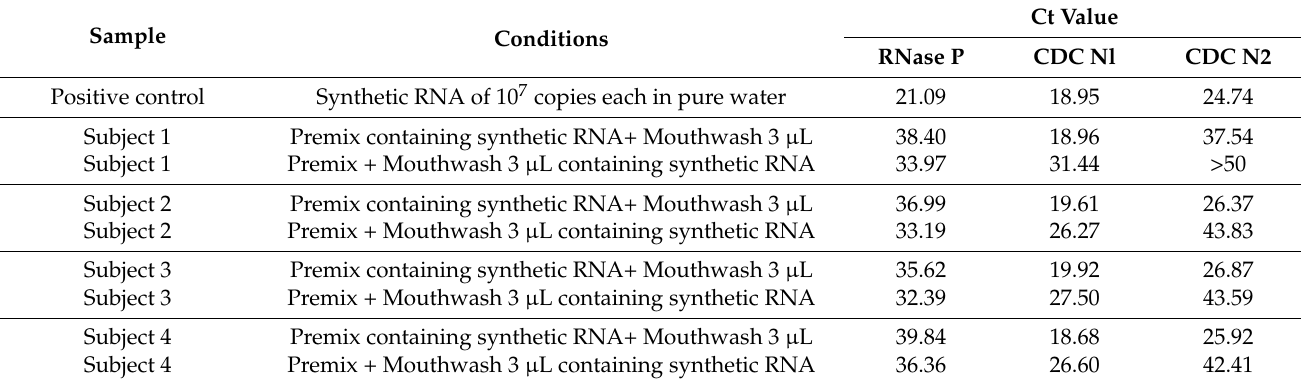
Table 7. Detection of SARS-CoV-2 synthetic RNA (CDC IM1, CDC IM2) mixed in saliva samples.